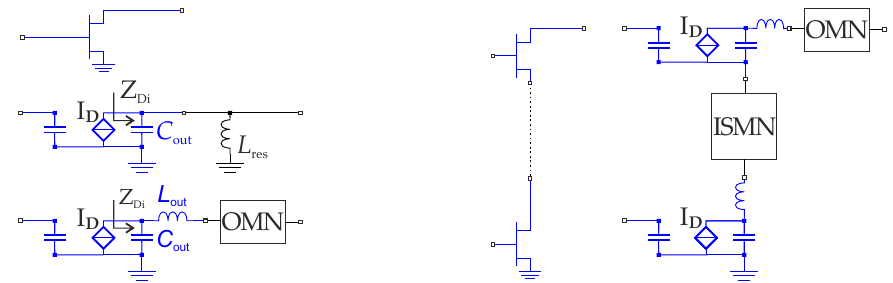
Figure 8. Schematic representation of the parasitic output effects of an individual transistor ( left ) and of two stacked transistors ( right